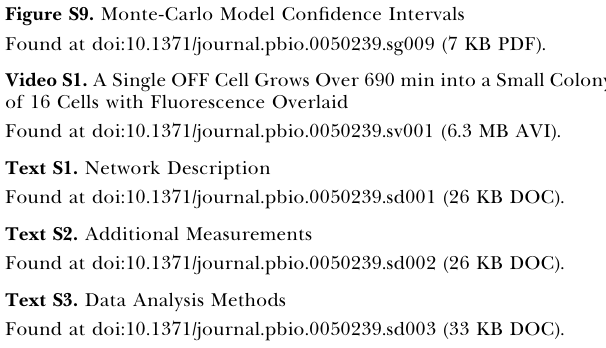
Figure S1. Growth for Selected Cell Colony in Measurement Chamber Remains Constant for Longer than our Typical Measurement Period Found at doi:10.1371/journal.pbio.0050239.sg001 (17 KB PDF). Figure S2. Histograms of Doubling Times as a Function of Previous Cell Divisions Found at doi:10.1371/journal.pbio.0050239.sg002 (10 KB PDF). Figure S3. Rapid Maturation of YFP Found at doi:10.1371/journal.pbio.0050239.sg003 (21 KB PDF). Figure S4. The Cumulative Percent of Cells That Have Switched Is Plotted against Their Marginal Switch Time Found at doi:10.1371/journal.pbio.0050239.sg004 (21 KB PDF). Figure S5. Corrective Factors Used to Weigh Data Points According to Their Significance Found at doi:10.1371/journal.pbio.0050239.sg005 (15 KB PDF). Figure S6. Schematic for Weighing the GM-GD Opportunity Windows and the Corresponding Window of Available Switch Times for the Example Family Tree Found at doi:10.1371/journal.pbio.0050239.sg006 (11 KB PDF). Figure S7. Opportunity Windows for M-D, GM-GD, and S1-S2 Cell Pairs Found at doi:10.1371/journal.pbio.0050239.sg007 (22 KB PDF). Figure S8. Overlay of Switching Patterns for all M-D, GM-GD, and S1- S2 Cell Pairs and Overlay of the Same in the Gillespie-Based Model Found at doi:10.1371/journal.pbio.0050239.sg008 (21 KB PDF). Figure S9. Monte-Carlo Model Confidence Intervals Found at doi:10.1371/journal.pbio.0050239.sg009 (7 KB PDF). Video S1. A Single OFF Cell Grows Over 690 min into a Small Colony of 16 Cells with Fluorescence Overlaid Found at doi:10.1371/journal.pbio.0050239.sv001 (6.3 MB AVI). Text S1. Network Description Found at doi:10.1371/journal.pbio.0050239.sd001 (26 KB DOC). Text S2. Additional Measurements Found at doi:10.1371/journal.pbio.0050239.sd002 (26 KB DOC). Text S3. Data Analysis Methods Found at doi:10.1371/journal.pbio.0050239.sd003 (33 KB